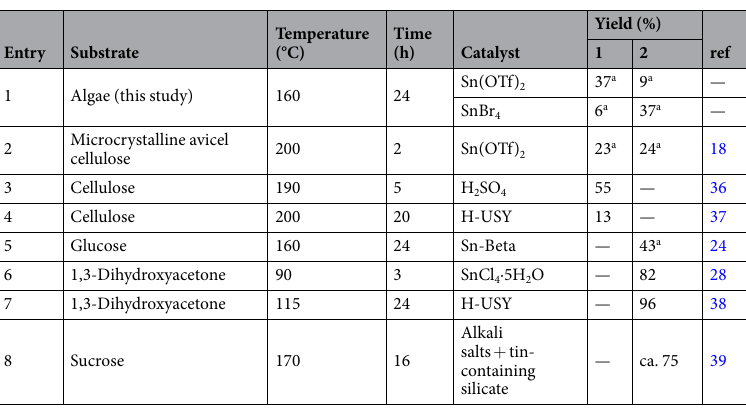
Table 5. Previous studies on the conversion of carbohydrates into methyl levulinate ( 1 ) and methyl lactate ( 2 ). a Yields are